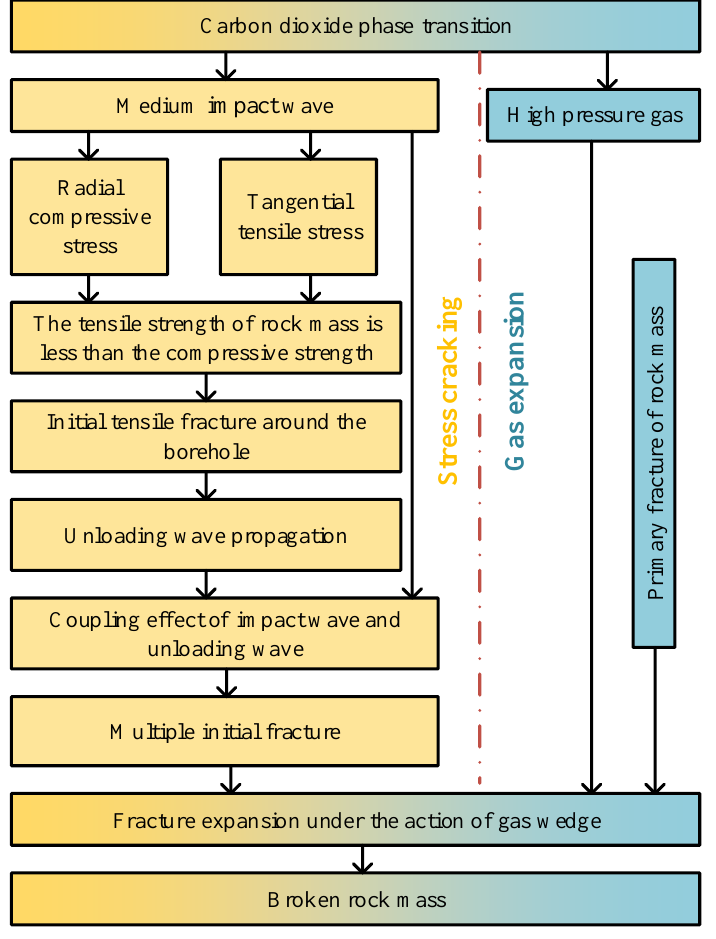
Figure 12. Fracture mechanism of carbon dioxide phase transition blasting.